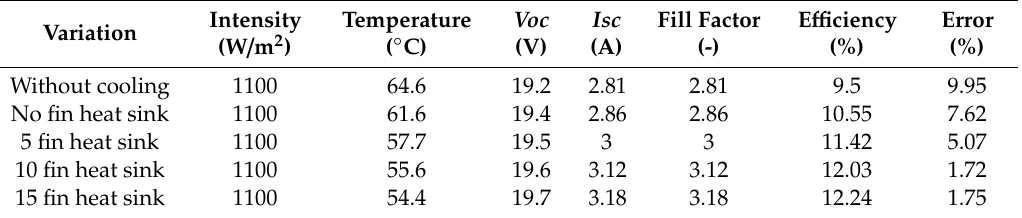
Table 2. Temperature and e ffi ciency of the solar cell.